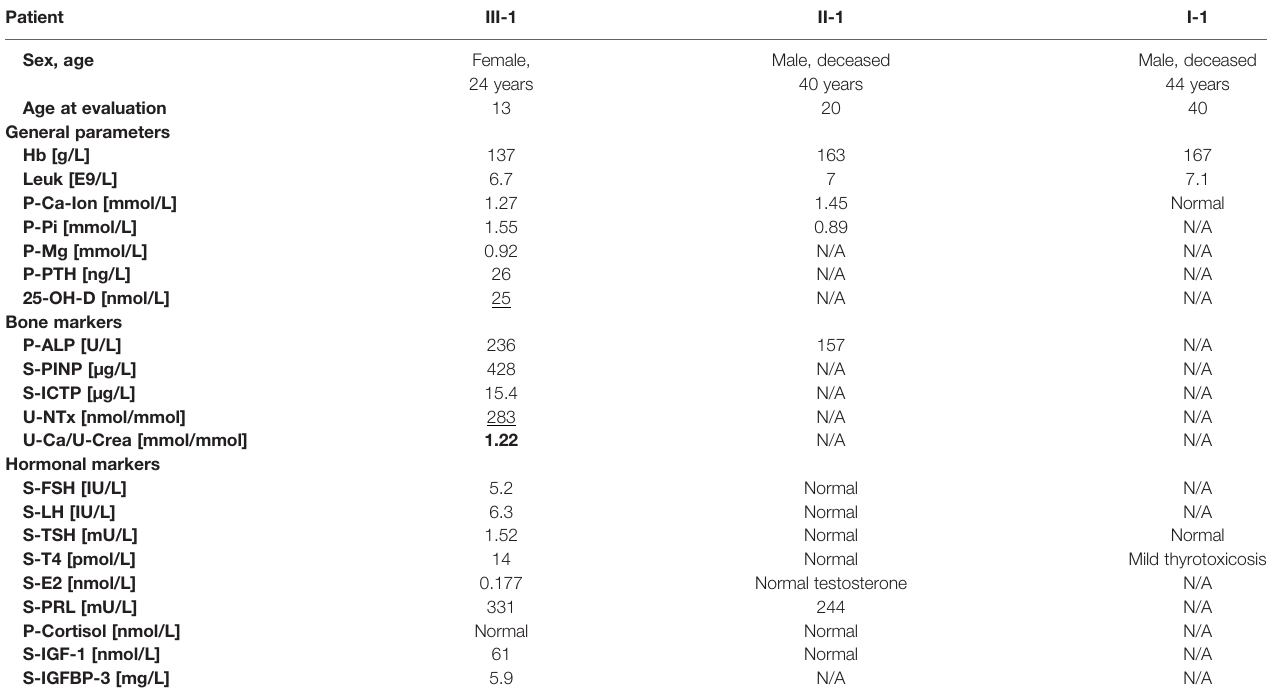
TABLE 1 | Biochemistry in three Finnish patients with a novel TBX2 missense mutation p.Thr300Met. Patient Sex,